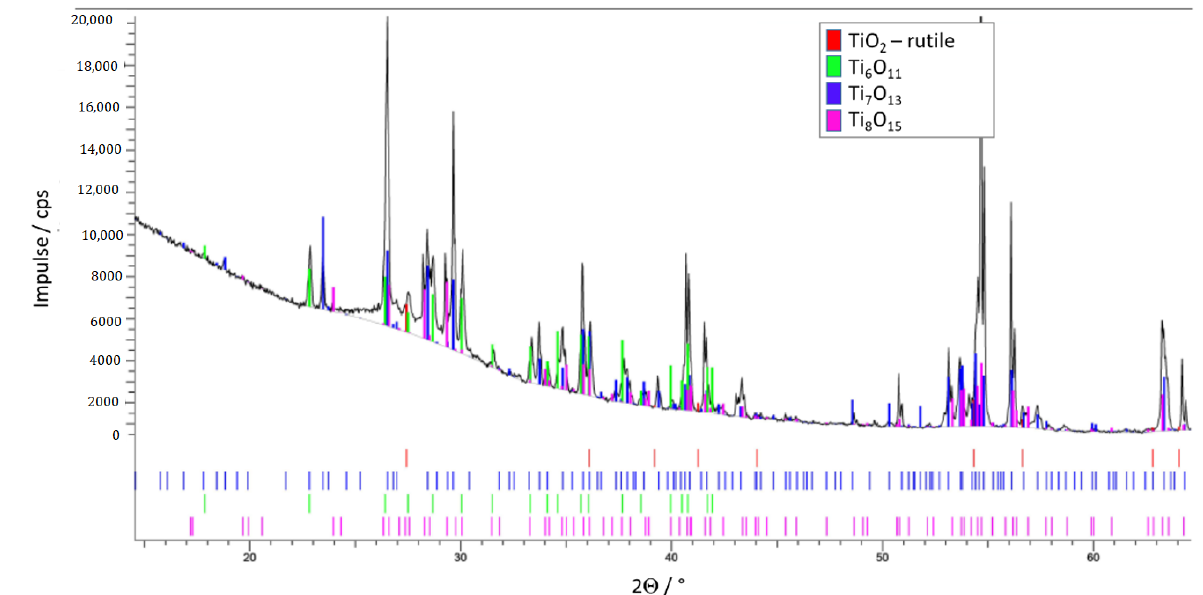
Figure 13. TiO x phases at the surface of the test samples.